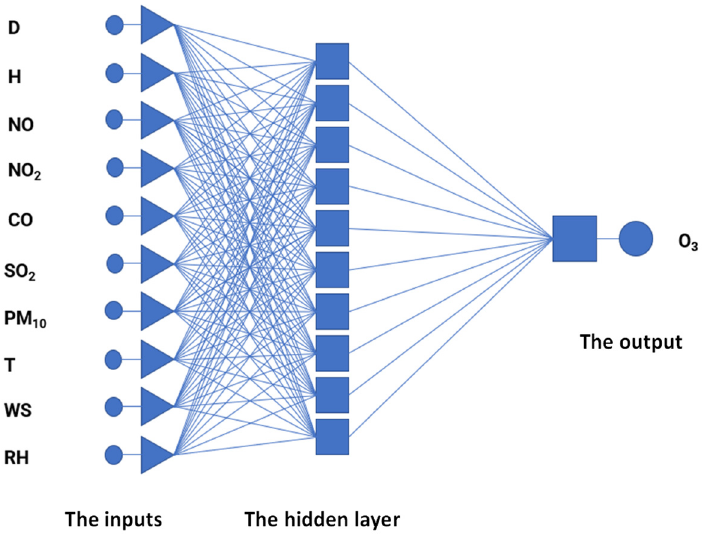
Figure 2. An architecture diagram of the multi-layer perceptron with ten neurons in a single hidden layer.